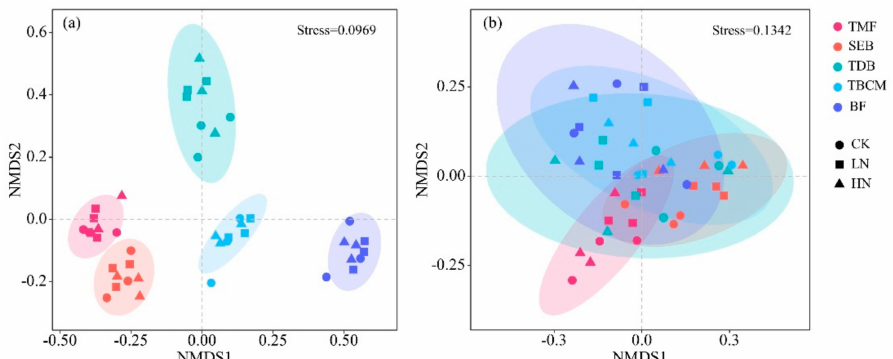
Figure 3. Nonmetric multidimensional scaling (NMDS) ordination plot based on the Bray–Curtis distance of samples for the fungal community structures ( a ) and fungal functional groups ( b ) in five forest types under different N treatments. TMF: tropical montane rain forest, SEB: subtropical evergreen broadleaved forest, TDB: temperate deciduous broadleaved forest, TBCM: temperate broadleaved and conifer mixed forest, BF: boreal forest.